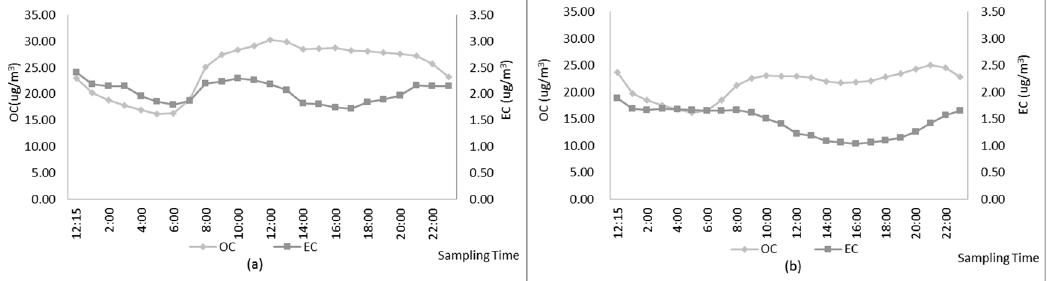
Figure 4. Heating and non-heating period variations of EC and OC concentration. Table 4. Average OC and EC concentration in PM 2.5 during heating and non-heating periods. Period